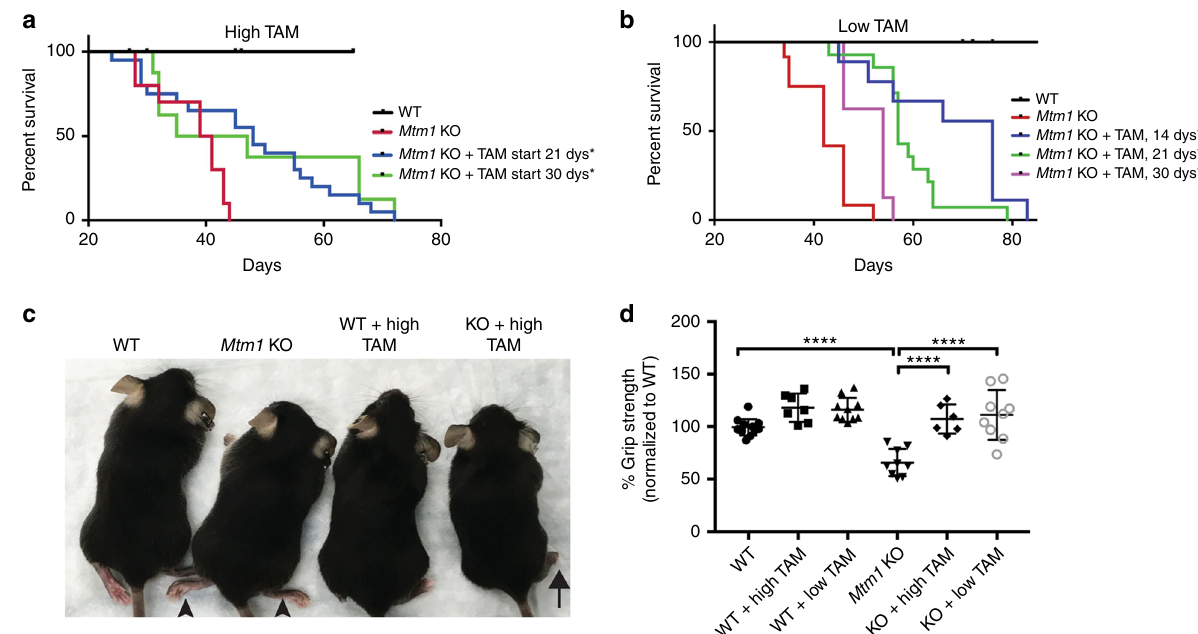
Fig. 1 Tamoxifen treatment prolongs survival and improves muscle strength in Mtm1 knockout mice. a High-dose Tamoxifen (TAM) treatment starting at 21 days promotes signi fi cant improvement in Mtm1 KO survival [median survival 48 days ( n = 20) vs. 39 days for untreated KOs ( n = 7), * p = 0.05]. High- dose treatment at 30 days does not improve survival in aggregate but does in the subset of treated animals surviving beyond the fi rst 2 days of treatment [subset median survival 66 days ( n = 5) vs. 41 days for untreated KOs ( n = 3), * p = 0.03]. b Low-dose TAM treatment starting 14, 21, or 30 days signi fi cantly improves Mtm1 KO survival. Low-dose TAM treatment starting 14 days has a median survival of 71 days ( n = 9) vs. 42 days for untreated KOs, *** p = 0.001. Low-dose TAM treatment starting 21 days median survival is 57 days ( n = 14) vs. 42 days for untreated KOs ( n = 5), **** p = 3.1 × 10 − 5 . Low- dose TAM treatment starting 30 days has a median survival of 54 days ( n = 8) vs. 44 days for untreated KOs ( n = 4), ** p = 0.004 c . Photomicrograph of WT, Mtm1 KO, and high-dose TAM treated WT and KOs. Untreated KOs have splayed hind limbs (arrowhead indicates limb weakness). High-dose TAM treated KOs have normal limb positioning and posture. d Grip strength was measured at 35 days of age. High-dose TAM treated KOs ( n = 6) have a mean grip strength of 107 ± 8%, vs. 65 ± 8% for untreated KOs ( n = 4), **** p < 0.0001; high-dose TAM treated WT having 118 ± 7% ( n = 7) vs. 100 ± 8% ( n = 7) for untreated WT. Low-dose TAM KOs ( n = 9) mean grip strength = 112 ± 8.9%, vs. 66 ± 10% for untreated KOs ( n = 5), **** p < 0.0001, while treated WT = 116 ± 9% ( n = 10), vs. 100 ± 10% for untreated WT ( n = 6). All values normalized to untreated WT. Statistical analysis by log-rank (Mantel-Cox) test, two-way ANOVA (Tukey ’ s multiple comparisons/Fisher ’ s least common differences post-test) or unpaired Student's t